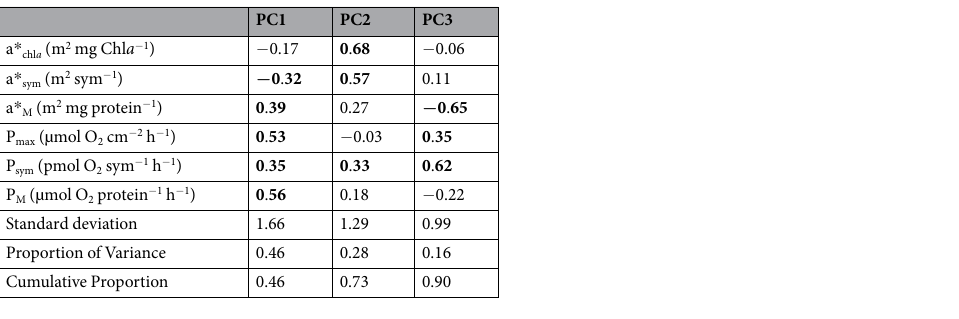
Table 2. Principal component analysis (PCA) loadings for the variation of the optical and photo-physiological traits of control and heat-stressed corals. The cumulative variation accounted for by each principal component is also shown. In bold are highlighted the highest correlations [loading > 0.3] between parameters and